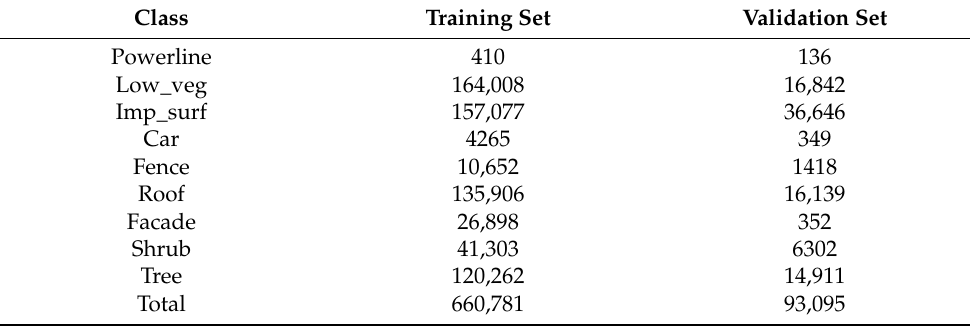
Table 2. The number of points and detailed category distribution of the Vaihingen 3D dataset. Low_veg and Imp_surf represent low vegetation and impervious surface, respectively.